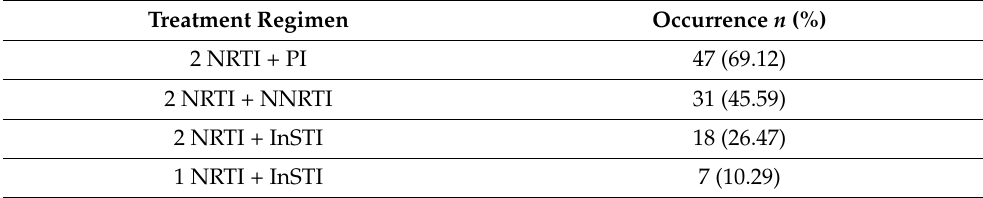
Table 2. Applied regimens of antiretroviral therapy.